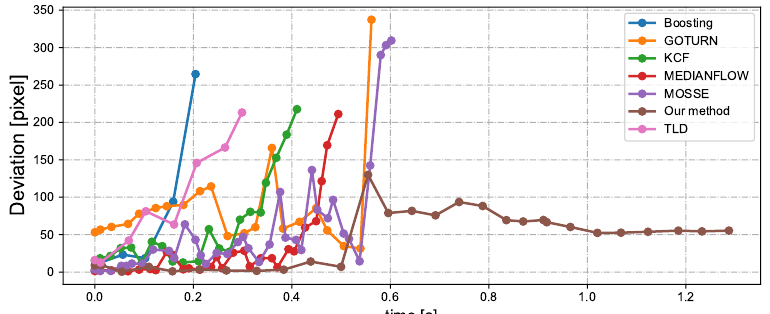
Figure 16. Pixel deviation value between the object position calculated by different algorithms and the object’s real position during